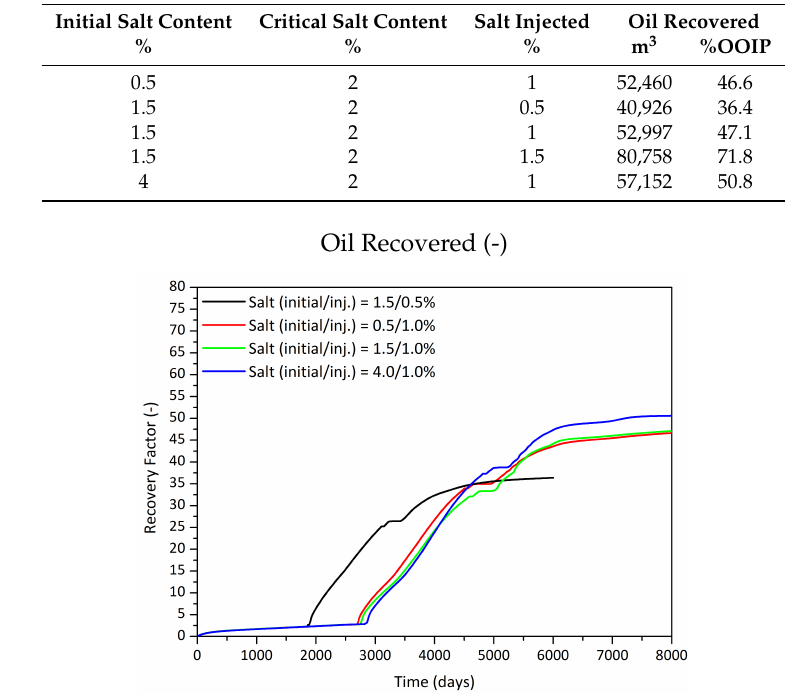
Table 7. Oil recovery efficiency as a function of the initial and injected salt concentrations in the reservoir.